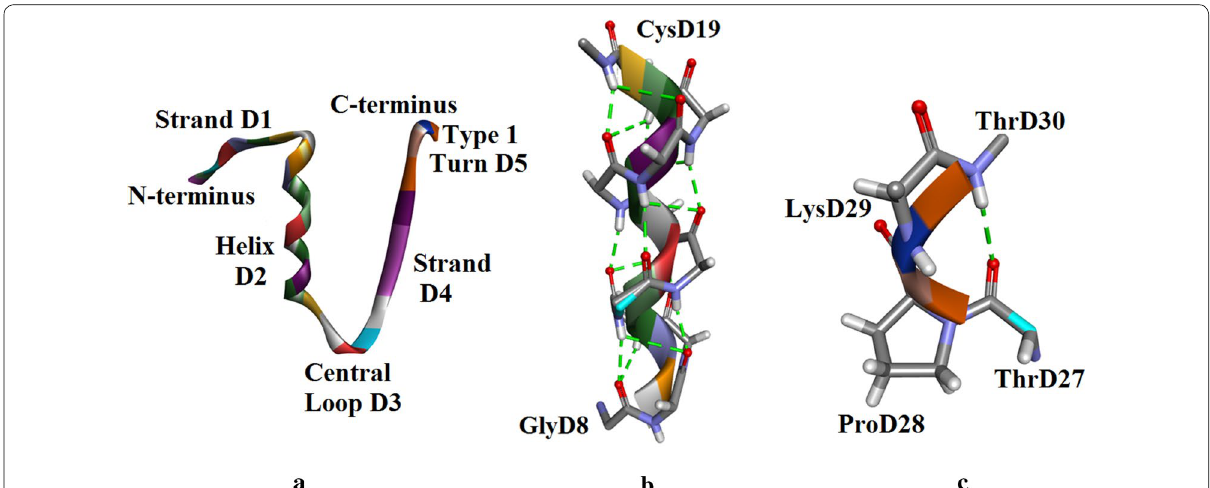
Fig. 7 a Insugen (I) chain D: secondary structure motifs. b Insugen (I) chain D helix D2. H‑bonds are shown as green dashed white lines . Main chain atoms only are shown. c Insugen (I) chain D: type I turn. Main chain atoms only are shown. The H‑bond is shown as a green dashed line . There is no corresponding secondary structure element in chain B, Fig. 6a. Drawn with Biovia, Discovery Studio 2016 [35]